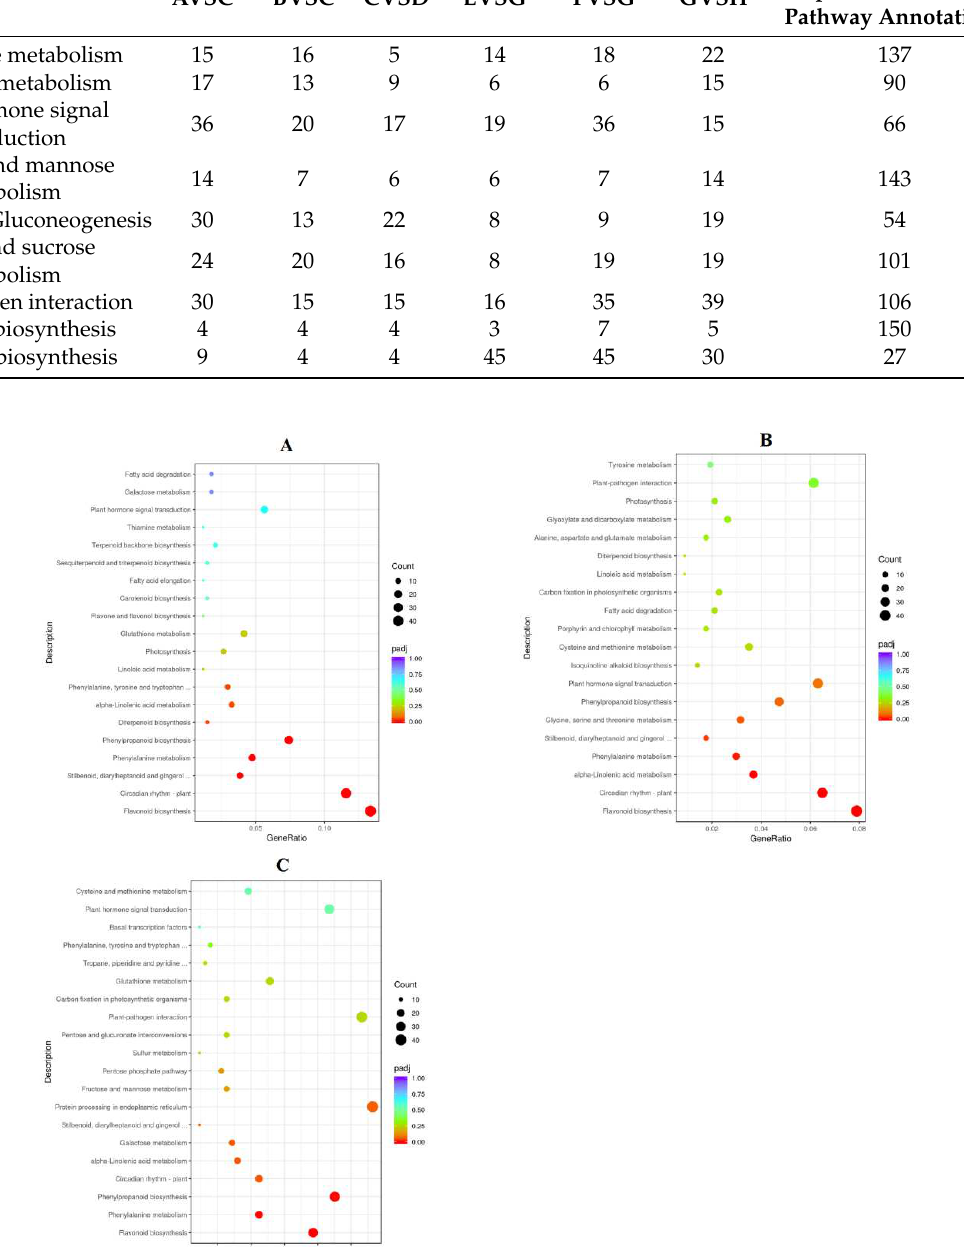
Figure 9. KEGG enrichment analysis of differentially expressed genes at 78 DAB. (( A ): E vs. G, ( B ): F vs. G, ( C ): H vs. G). Table 6. Overview of KEGG analysis of differentially expressed genes.